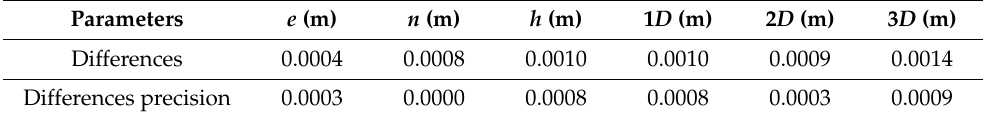
Table 3. The east (e), north (n), height (h), 1D, 2D, and 3D position differences.